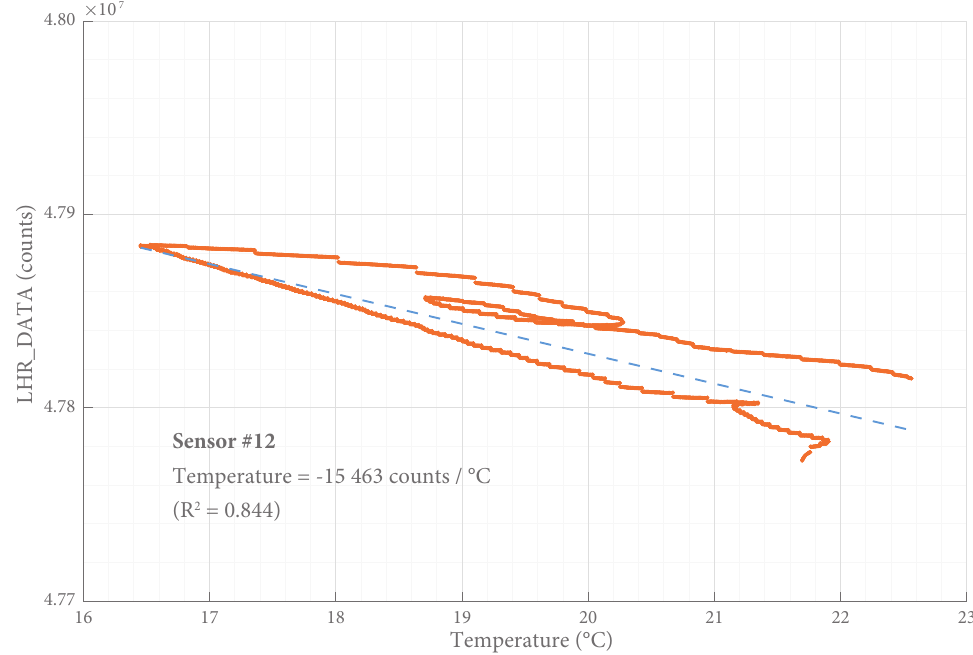
Figure 8. Temperature influence. About 85 % of the changes in output signal can be explained by fluctuations in temperature. It is not clear if this temperature influence is independent of the observed time drift and the load applied. The typical sensitivity (Table 2) can be used to convert LHR_DATA to a measure for force: 1500 counts approximate 0.01 N.